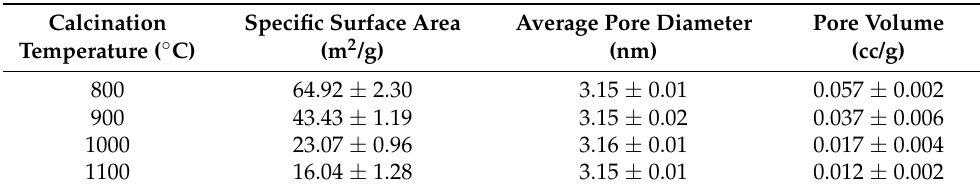
Table 1. Specific surface area, average pore diameter, and pore volume of β -TCP powders calcined at temperatures of 800, 900, 1000, and 1100 ◦ C.